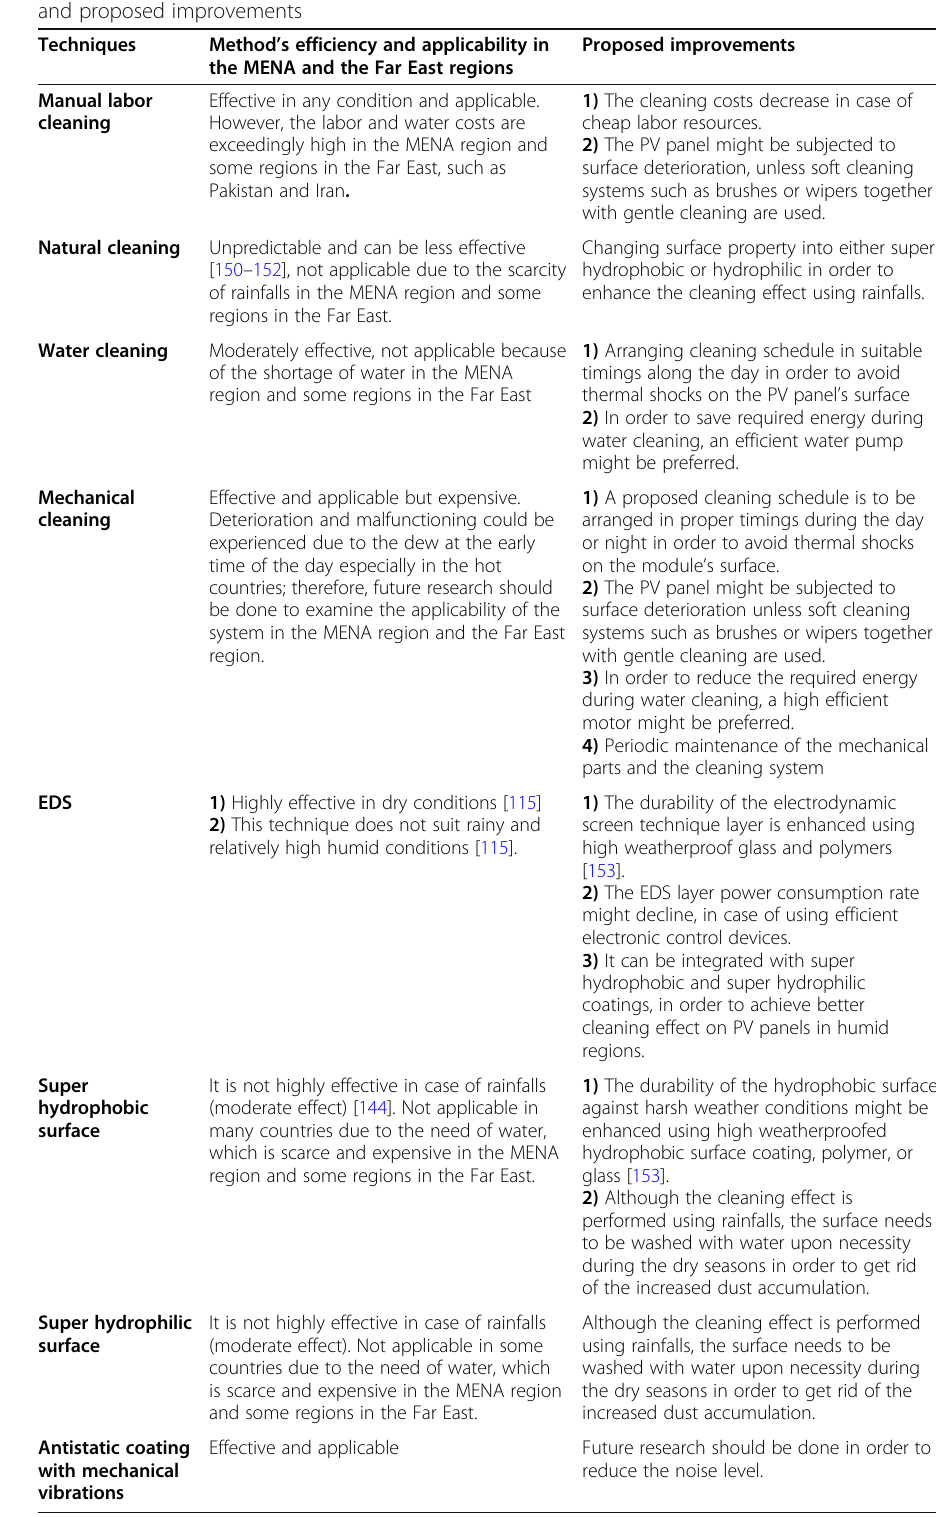
Table 4 A comparison between the different cleaning methods regarding efficiency,